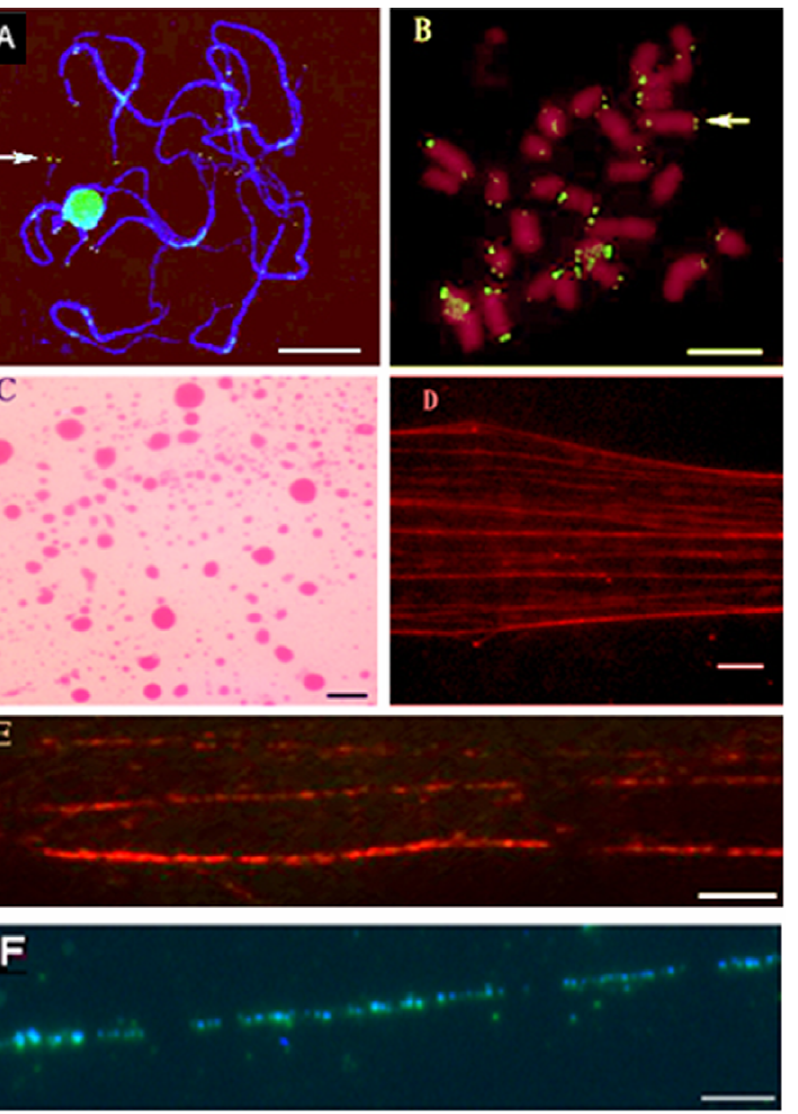
Figure 1. Fluorescence insitu hybridization patterns on pachytene chromosomes and DNA fibers of diploid cotton, Gossypium arboreum . A . FISH of telomeres on pachytene chromosomes. The Arabidopsis -type telomere probe was labeled with biotin and detected with avidin- fluorescein. The arrow indicates the separation of bivalents on the end of pachytene chromosomes, brilliant blue is heterochromatin and dark-blue is euchromatin. B . FISH of telomeres on metaphase chromosomes. The telomere probe was labeled with biotin and detected with avidin-fluorescein. The arrow indicates the telomere signal. C . Nuclei prepared with the chopping method, the big dots are nuclei with partly cytoplasm. D . The extended cotton DNA fibers prepared from nuclei. E . Cotton DNA fibers hybridized with genome DNA probes labeled with rhodamine-conjugated and detected with anti-digoxigenin antibody. F . Cotton DNA fibers hybridized with 45S rDNA probes labeled with biotin and detected with avidin- fluorescein. The chromosomes in A-F were counterstained with DAPI. (A, B Bars=5 m m; C, D, E, F Bars=10 m m).